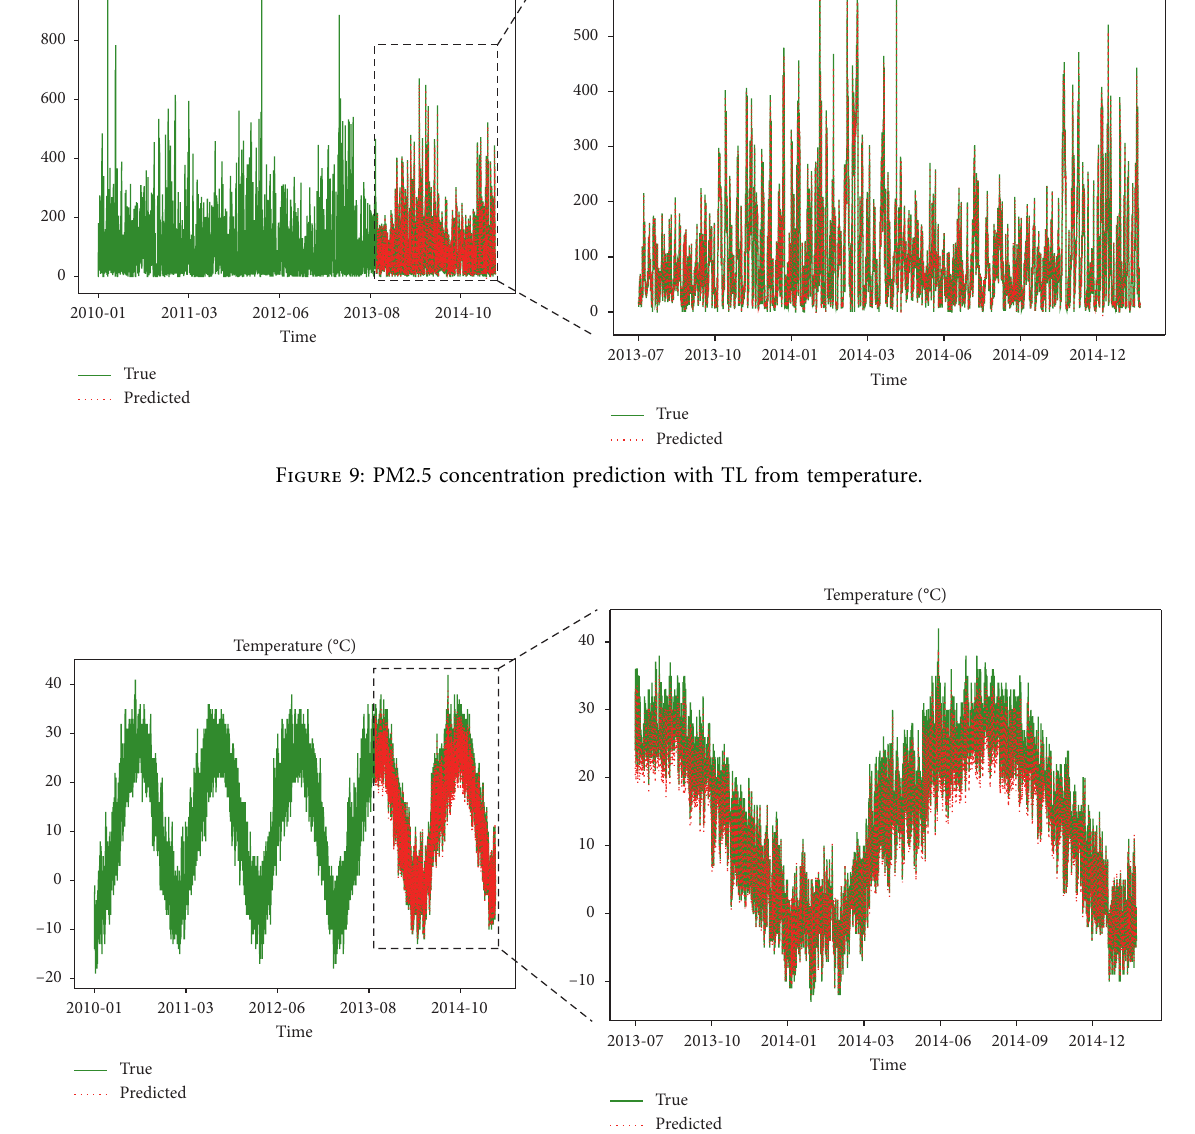
Figure 10: Temperature prediction without TL from PM2.5